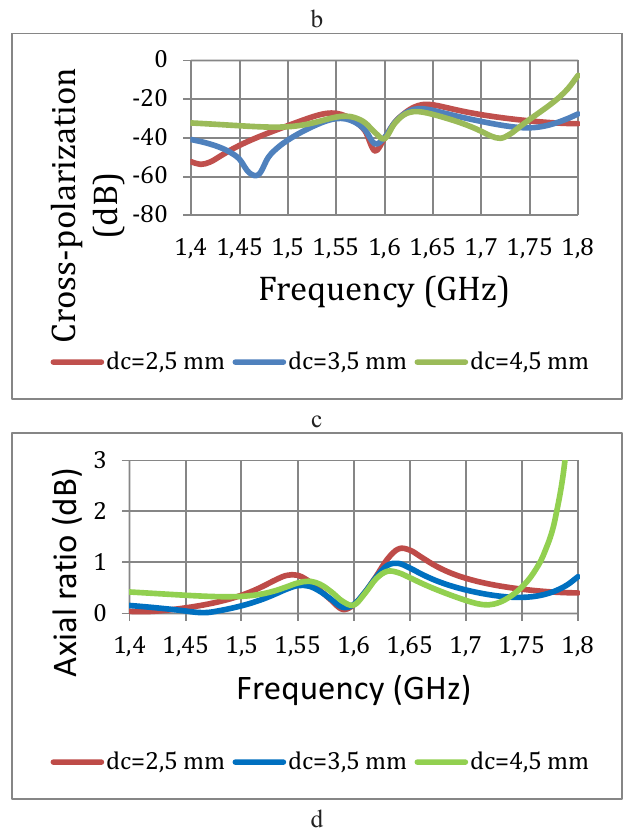
Fig. 6. (a) Gain, (b) reflection coefficient, (c) cross- polarization, and (d) axial ratio vs. frequency at d c = 2.5, 3.5, and 4.5 ( L c =